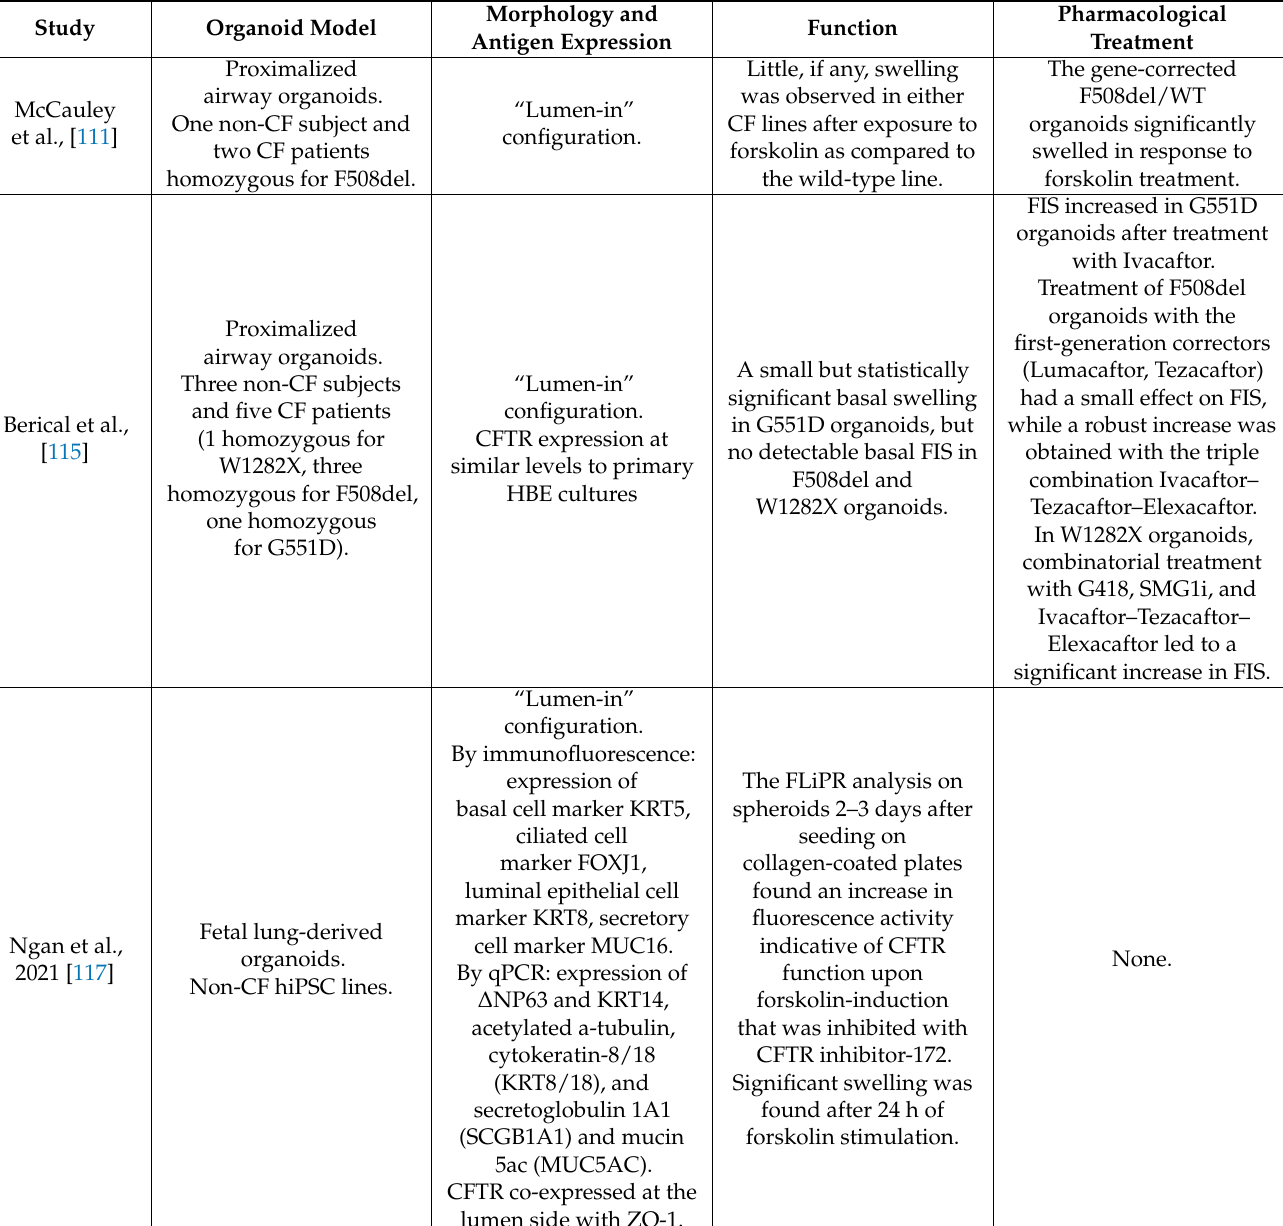
Table 2. Airway organoids obtained from induced pluripotent stem